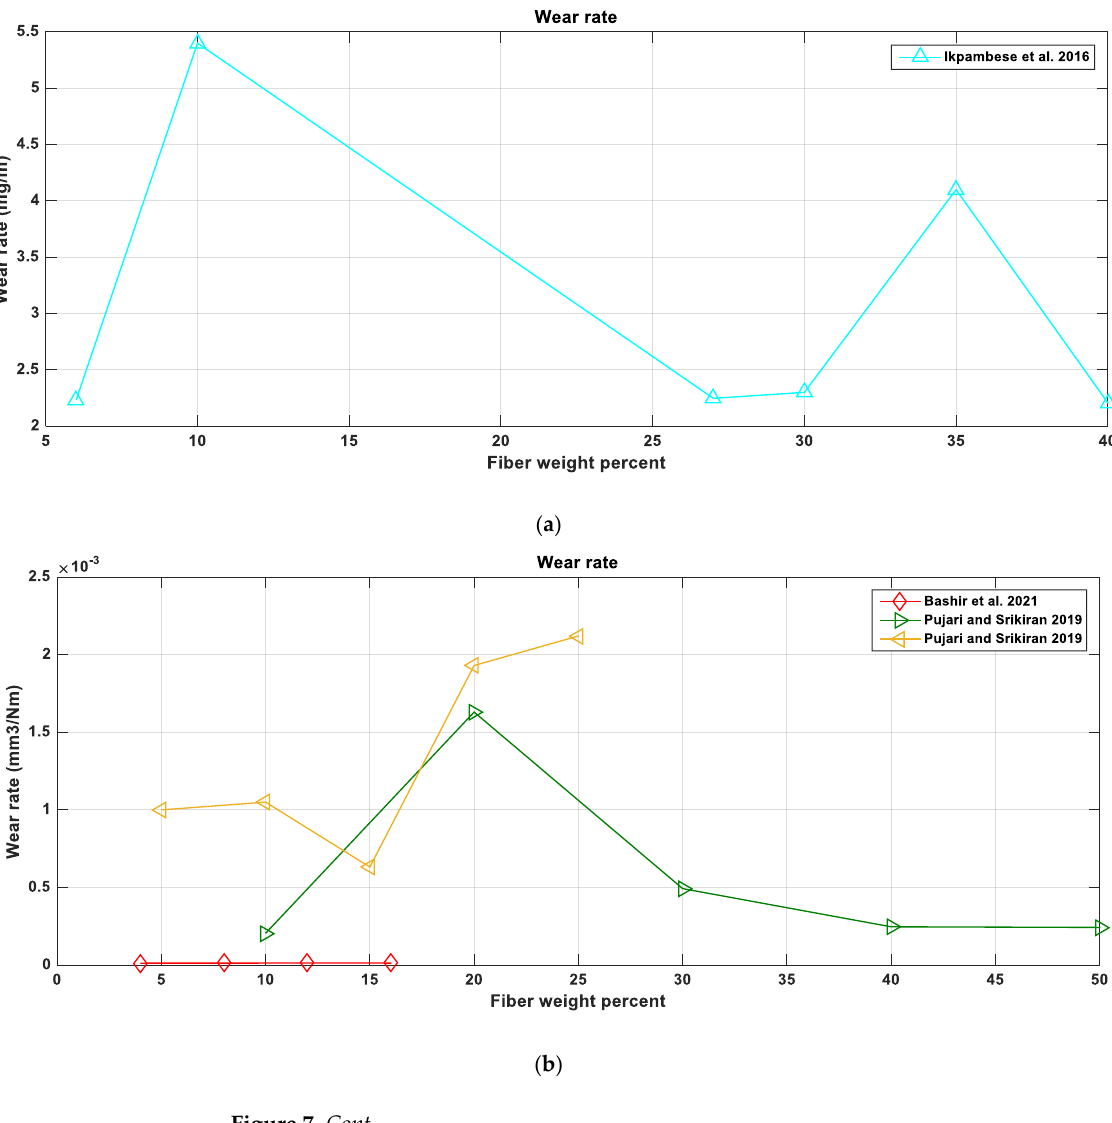
Figure 6. The variation of COF for different fibers with a variation in the fiber weight percentage Figure 6. ThevariationofCOFfordifferentfiberswithavariationinthefiberweightpercentage[43,44,56,67]. [43,44,56,67].